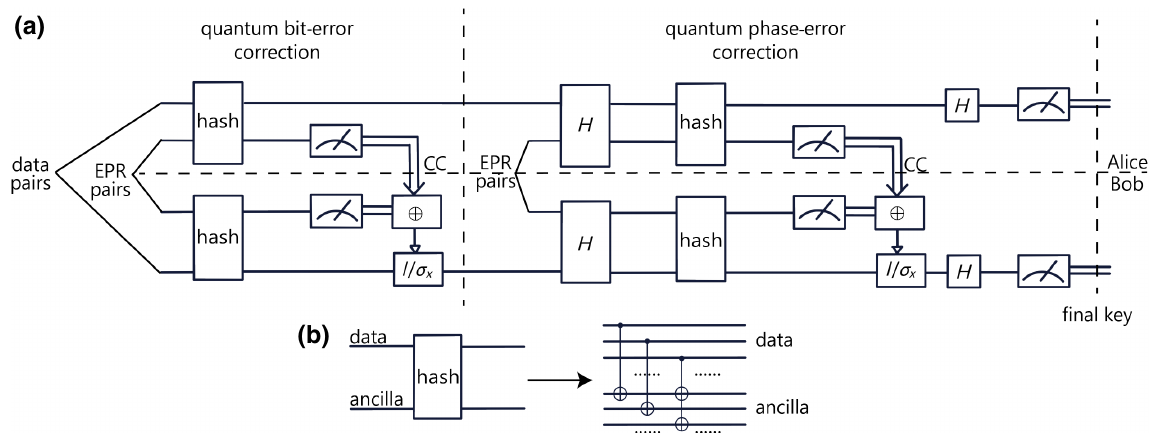
FIG. 1. (a) Quantum bit- and phase-error correction. The measurements in all the figures are Z -basis measurements by default. “CC” is short for classical communication. The ⊕ operation means XOR operations on classical bit strings. H represents the Hadamard gate applied to each of the involved qubits. I /σ x represents an identity or σ x operation on the qubits, depending on the error syndrome. (b) In the linear case, the hash functions can be represented by matrices and realized by a series of controlled- NOT ( CNOT ) gates between the data (as control) and ancillary (as target) qubits. The measurement outcomes of ancillary qubits would give the parity information of the data